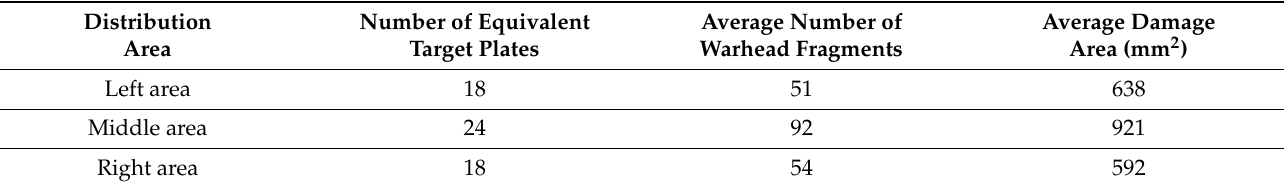
Table 2. Test data of equivalent target plate at 41.8 m.